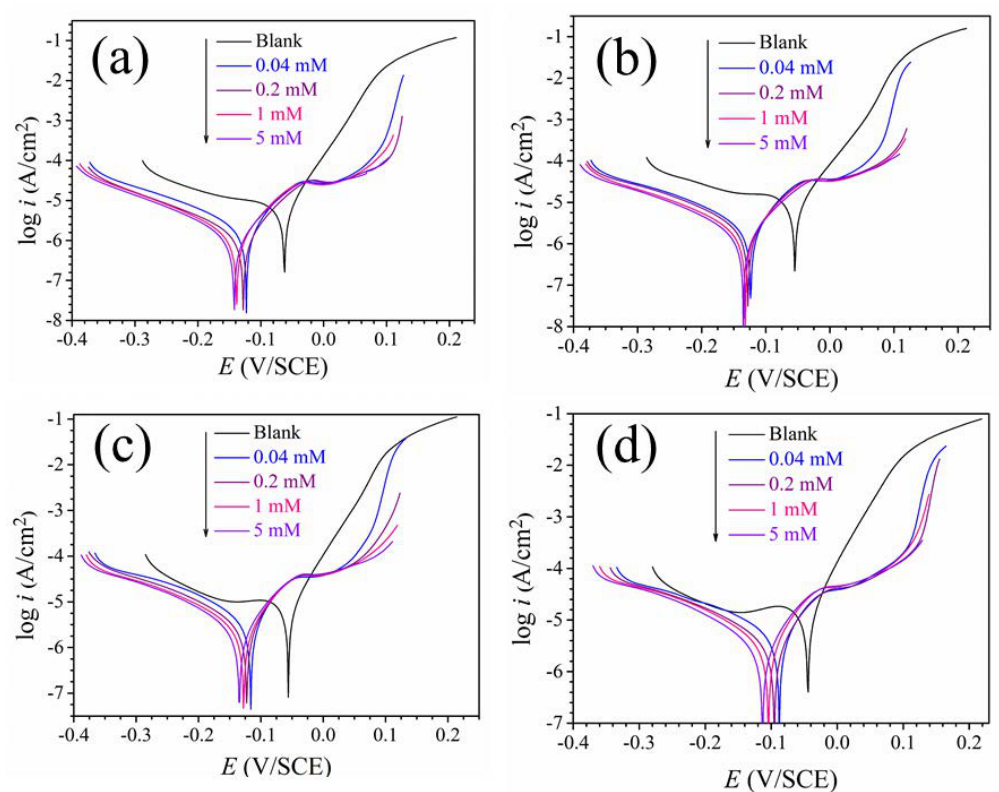
Figure 3. Polarization plots of Cu at different temperatures in 0.5 mol/L H 2 SO 4 with and without itraconazole: ( a ) 298 K, ( b ) 303 K, ( c ) 308 K, and ( d ) 313 K.